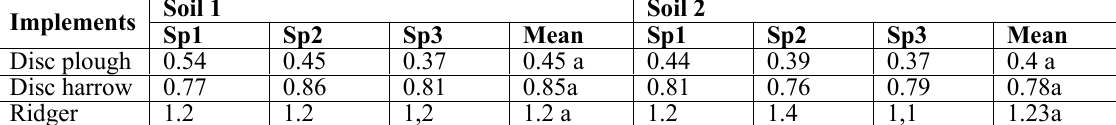
Table 6. Effect of different forward speeds and two different soils on Effective field capacity (ha/hr) Soil 1 Soil 2 Implements Sp1 Disc plough Disc harrow 0.77 Ridger Means with the same letters are not significantly different Soil 1: Food security